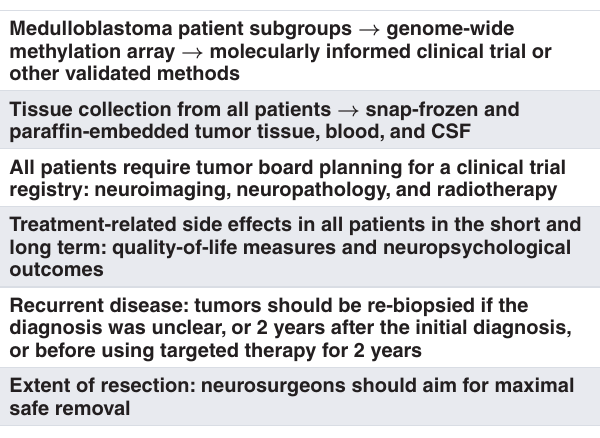
Table 3. Adapted table of a proposed consensus for designing the next generation of clinical trials in medulloblastoma (Ramaswamy et al. 14